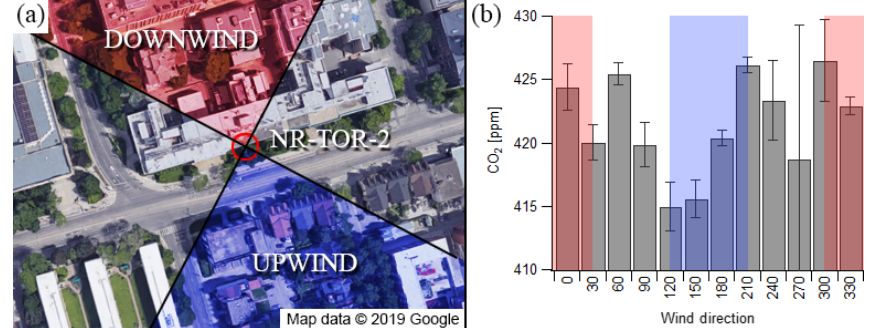
Figure 2. Satellite image of the NR-TOR-2 site, along with upwind (blue) and downwind (red) quadrant definitions. Meteorological mea- surements were recorded on the roof of the facility (labelled: NR-TOR-2) (a) . Average ambient CO 2 concentrations by wind direction, with upwind and downwind definitions again highlighted in blue and red, respectively. Error bars are 95% confidence intervals on the mean (b)